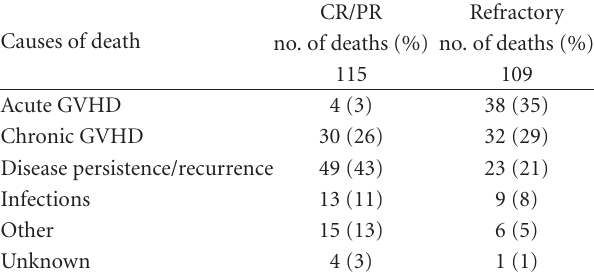
Table 4: Primary cause of death among patients with